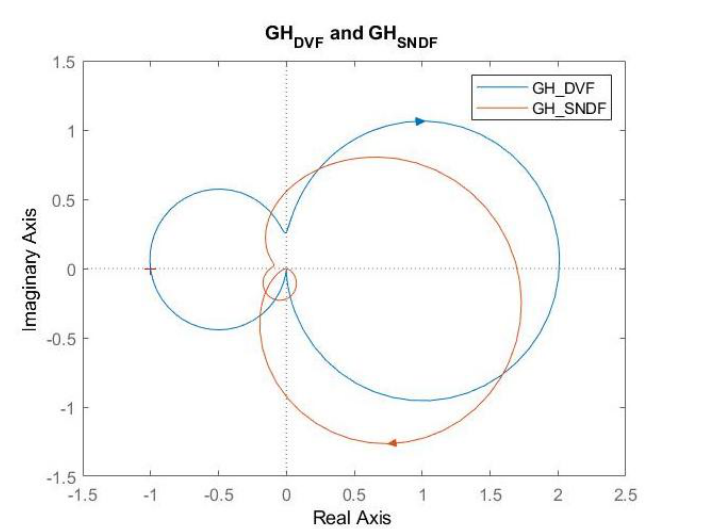
Figure 2. Nyquist plots of the open − loop transfer function GH ( s ) for DVF (blue line) and SNDF (red line) control